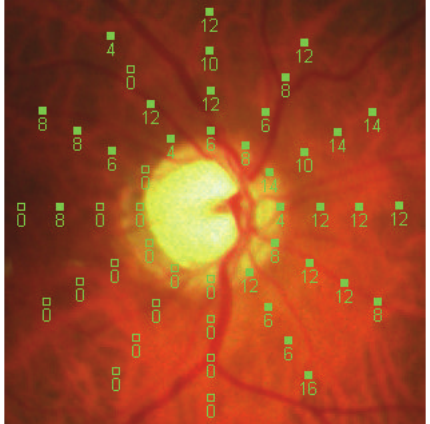
Figure 2: Analysis of the peripapillary retinal sensitivity by Mp-1 projecting light stimuli in radial manner to the optic papillae (12